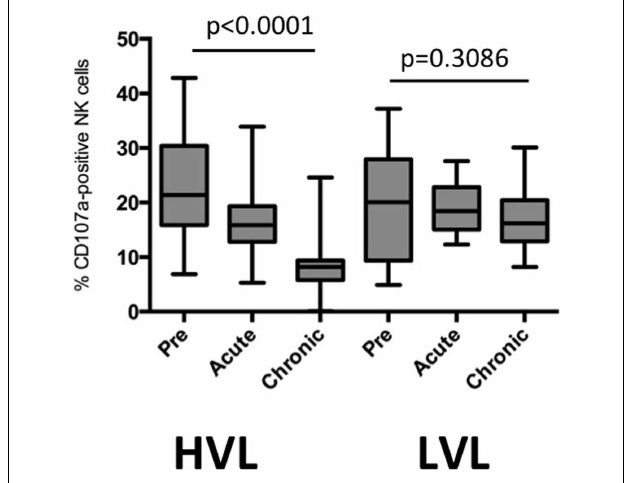
FIGURE 3 | Cytotoxic capacity of NK cells during different phases of SIV infection in HVL and LVL animals . Degranulation after stimulation with MHC class I-deficient cells was determined as % CD107a-positive NK cells. Acute and chronic phases represent time points 2–4weeks and > 16weeks after